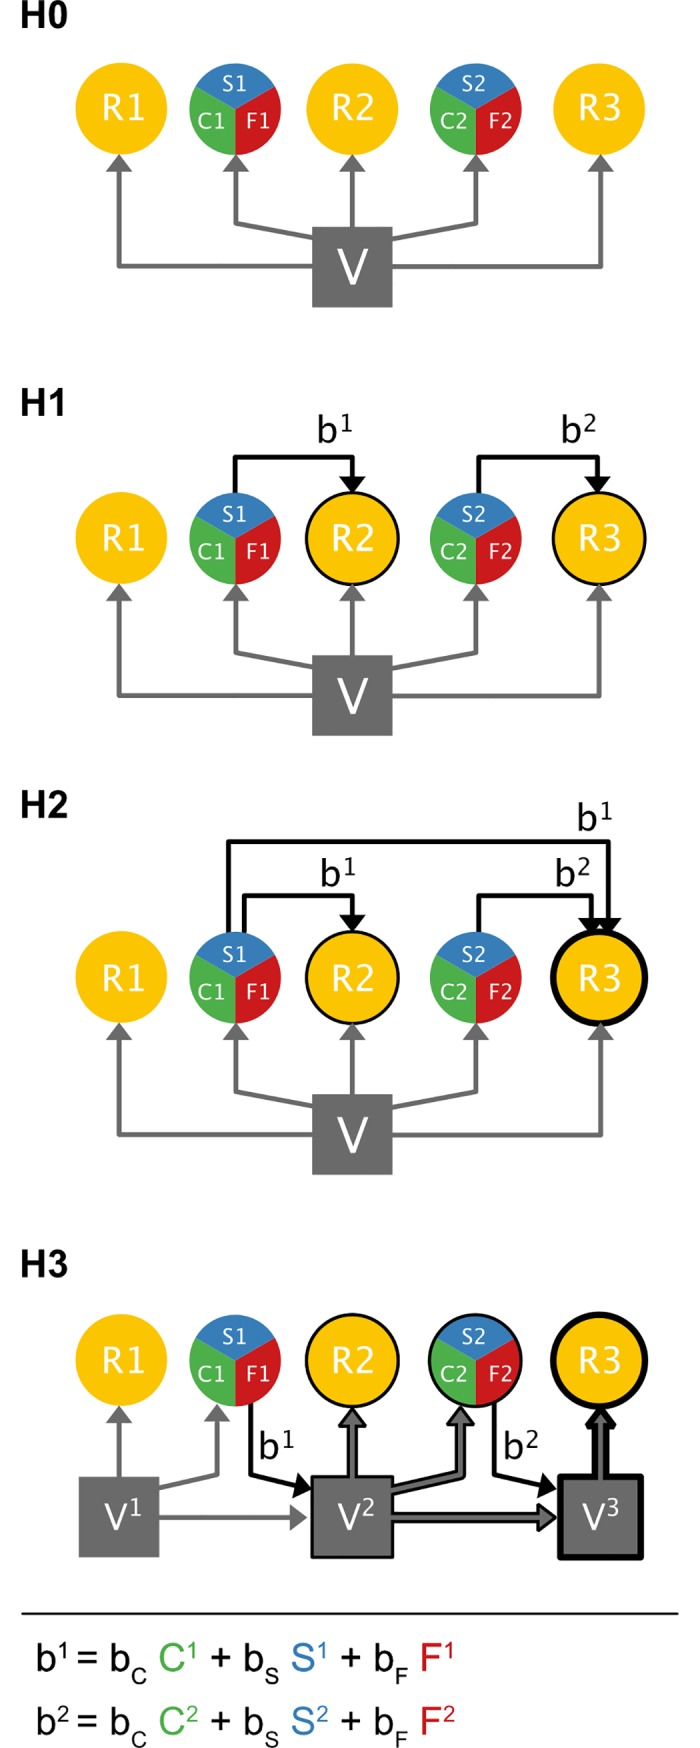
Model space.Schematic representation of the four hypotheses formalized in computational models. Colored circles represent behavioral responses in the rating and effort tasks: likeability rating (R) in yellow, choice (C) in green, success (S) in blue, and force (F) in red, the number indicating task session. Grey squares represent hidden values (V) of food items. Circles and squares are outlined in black, with line thickness indicating the cumulative impact of past actions. Black arrows represent the influence of past actions (b corresponding to the total bias, cumulated over action-related factors, as detailed in Eq 2). Grey arrows represent the influence of item values (V) on both declarative judgments (ratings) and actions (choice / success / force). The models differ by the extent of changes induced by action-related factors involved in the effort task: none in H0, restricted to next ratings in H1, extended to all subsequent ratings in H2, and generalized to all subsequent behaviors (both ratings and actions) in H3.